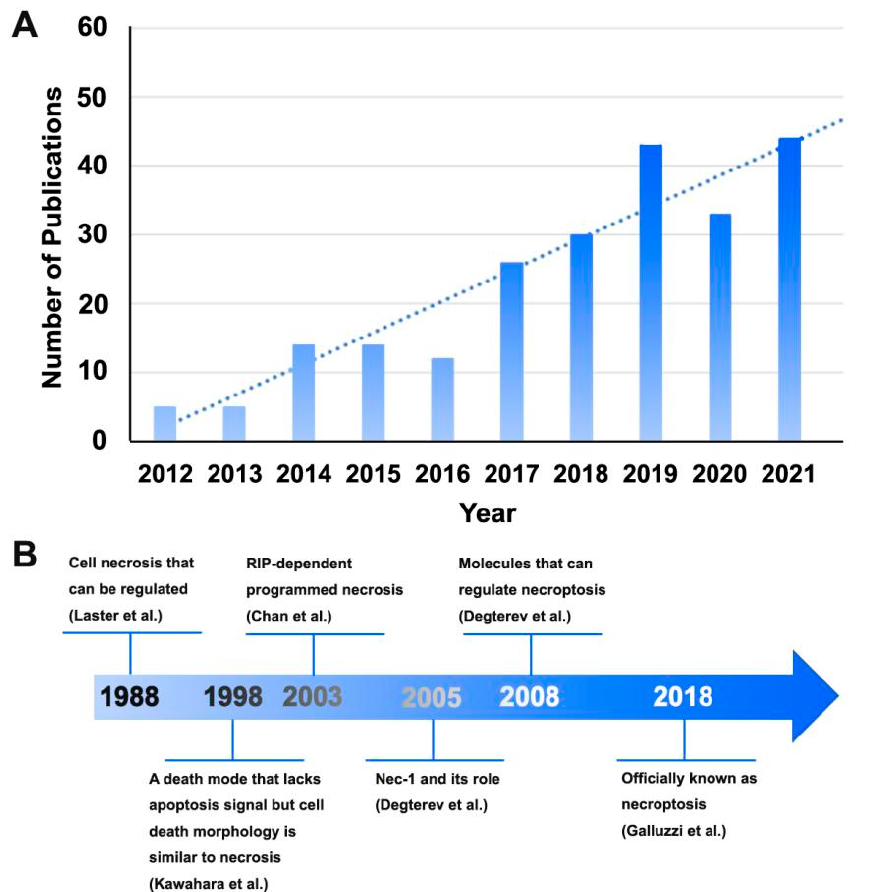
Figure 3. Global trends in the publication of necroptosis-related articles in the field of neuroscience analyzed via bibliometric analysis. ( A ) The number of articles published worldwide shows a steady upward trend. ( B ) The key nodes of necroptosis research [65,141–145].